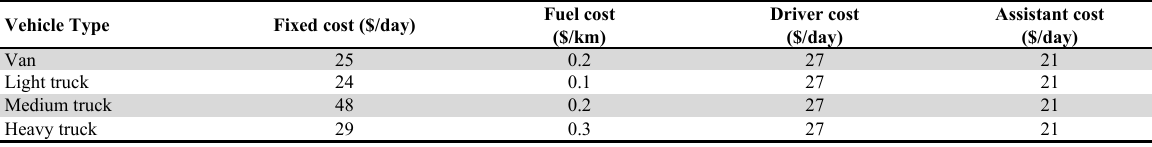
Roadway vehicle costs